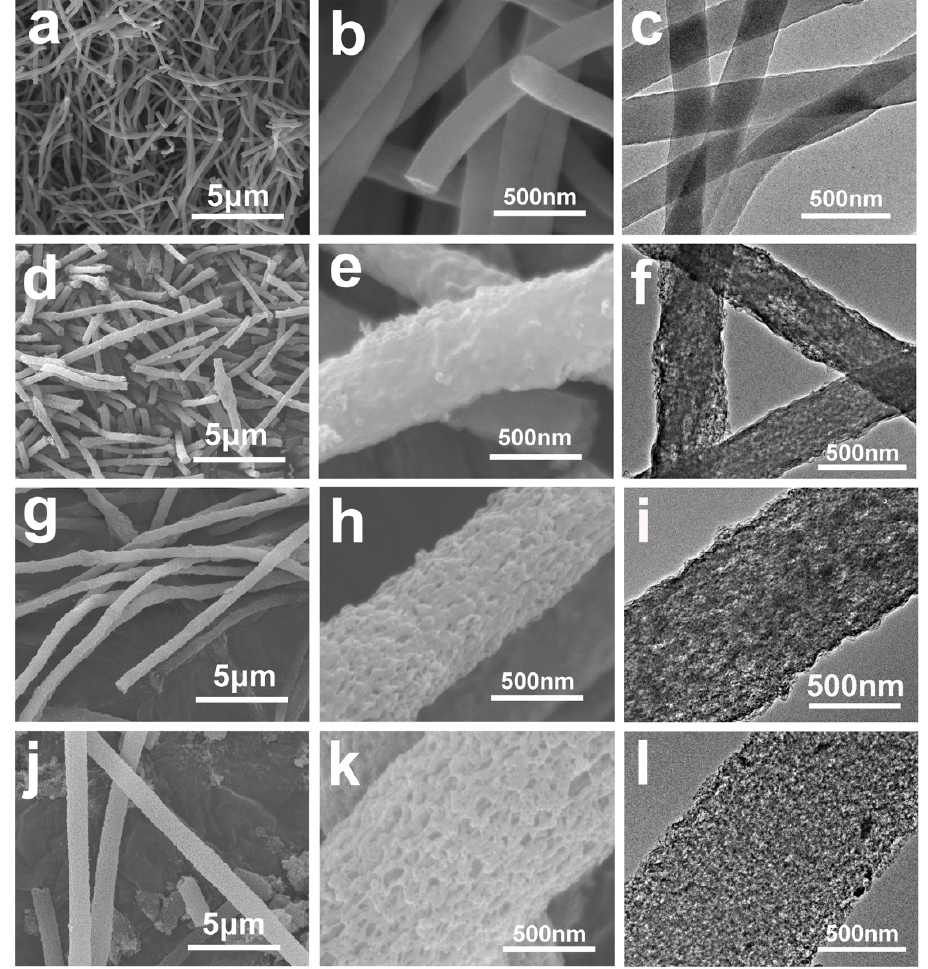
Figure 1. FESEM images ( a , b , d , e , g , h , j , k ) and TEM images of different carbon fibers. ( a – c ) CPAN, ( d – f ) NPCF-1, ( g – i ) NPCF-2, ( j – l ) NPCF-3.